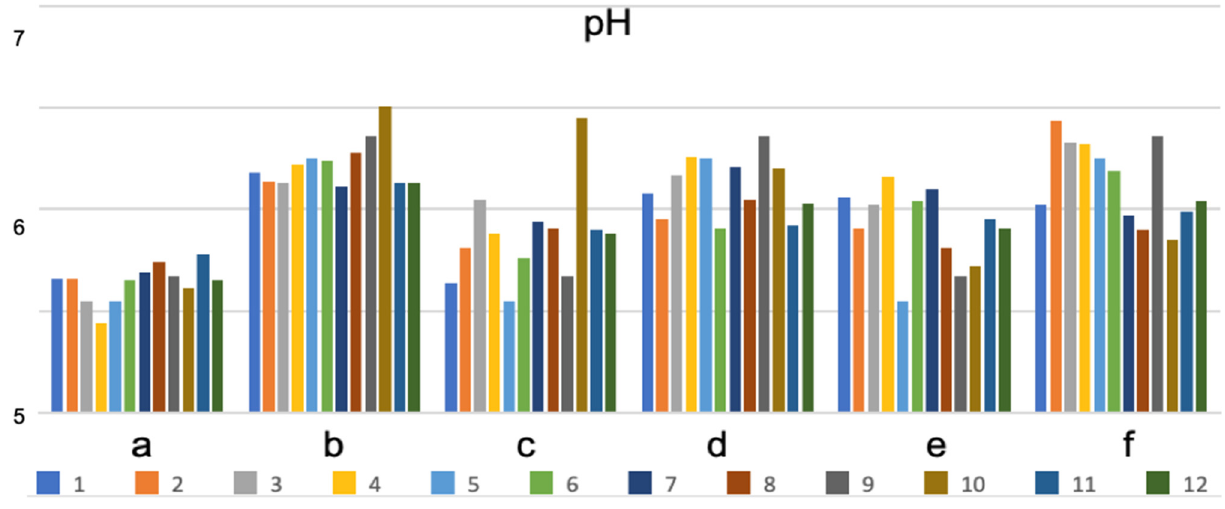
Figure 3. Changes in pH across the various marinated chicken breast meat samples before and after oven-grilling. The different letters (shown along the x -axis) represent as follows: (a) CP before oven- grill; (b) CP after oven-grill; (c) GP before oven-grill; (d) GP after oven-grill; (e) BS before oven-grill; (f) BS after oven-grill. The numbers representing the different color shades are as follows: (1) control (antioxidant additive % = 0.0); (2) control (antioxidant additive % = 0.5); (3) control (antioxidant additive % = 1.0); (4) control (antioxidant additive % = 1.5); (5) AS (antioxidant additive % = 0.0); (6) AS (antioxidant additive % = 0.5); (7) AS (antioxidant additive % = 1.0); (8) AS (antioxidant additive % = 1.5); (9) IM (antioxidant additive % = 0.0); (10) IM (antioxidant additive % = 0.5); (11) IM (antioxidant additive % = 1.0); (12) IM (antioxidant additive % = 1.5). African spice: AS; industrial marinade/pickle: IM; CP: cranberry pomace; GP: grape pomace; BS: Baikal skullcap.